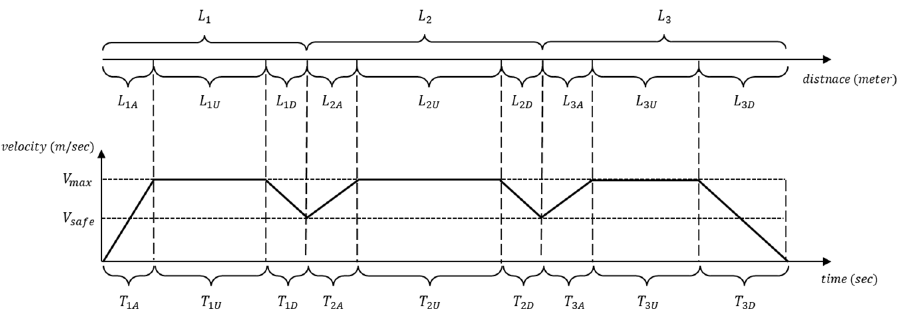
Figure 1. Example of the indoor robot movement from origin to destination in a multi-story building.